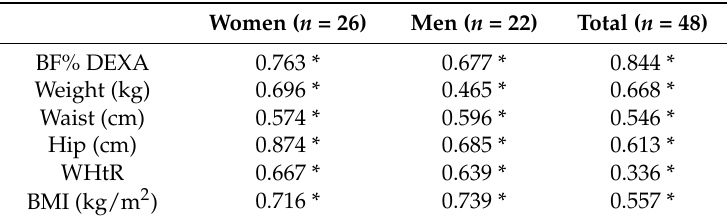
Table 2. Partial correlation coefficients between BF% determined by BAI and different anthropometric variables controlled by sex and